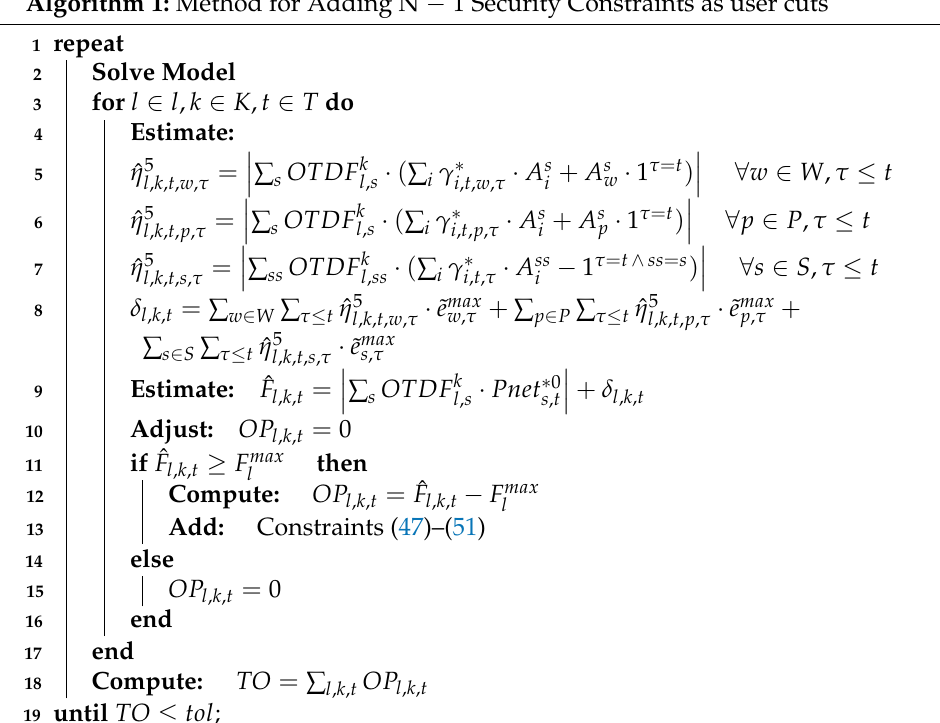
Algorithm 1 iteratively defines the feasible region of the SCUC, by adding